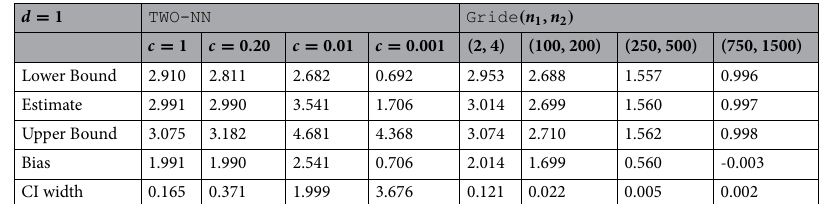
( n 1 , n 2 ) are presented d , and the width of the −